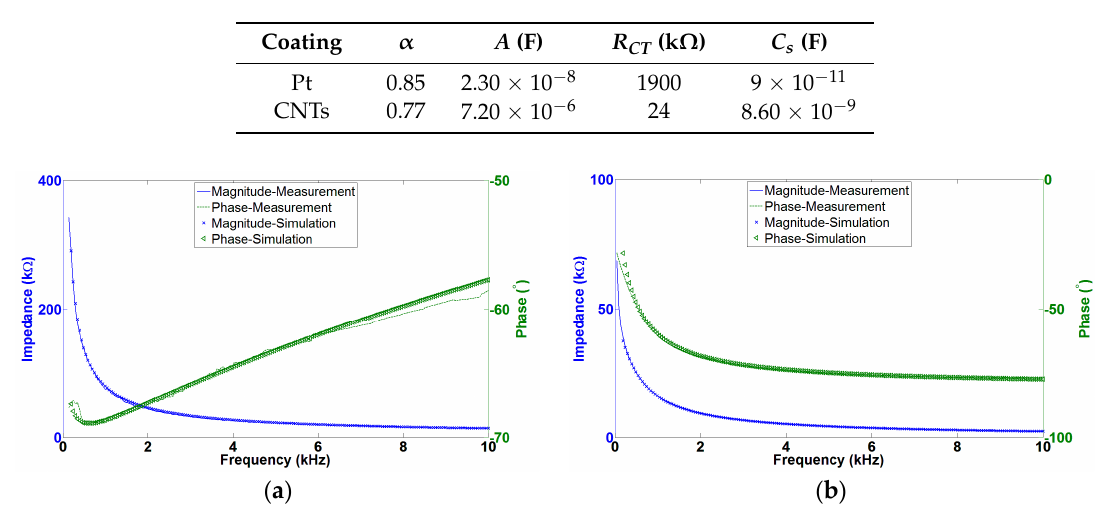
Figure 13. Simulation and experimental results of equivalent electrode-electrolyte interface: ( a ) Pt-tips; and ( b ) CNT-tips.